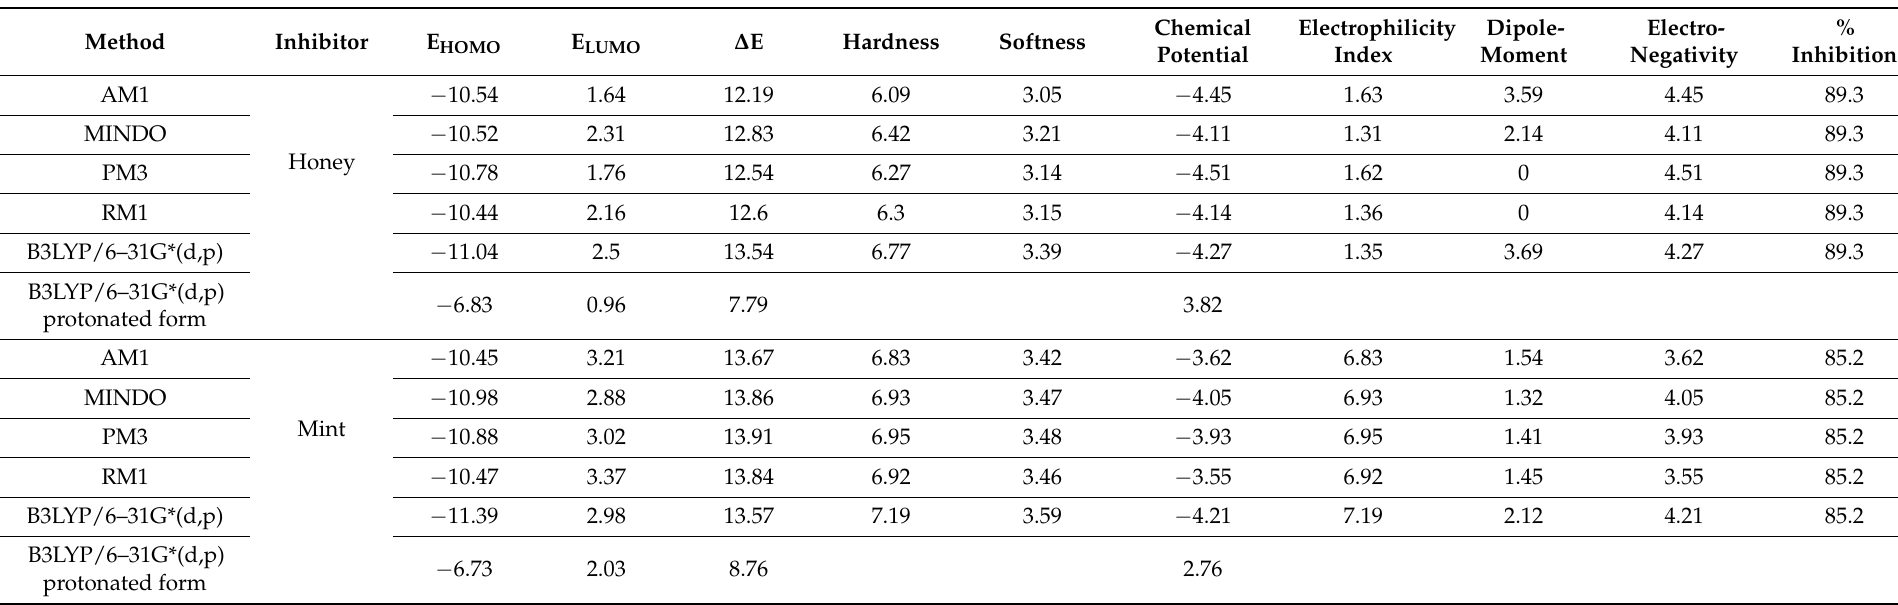
Table 1. Gas-phase AM1, MNDO, PM3, RM1, and B3LYP/6–31G*(d,p) data for honey and